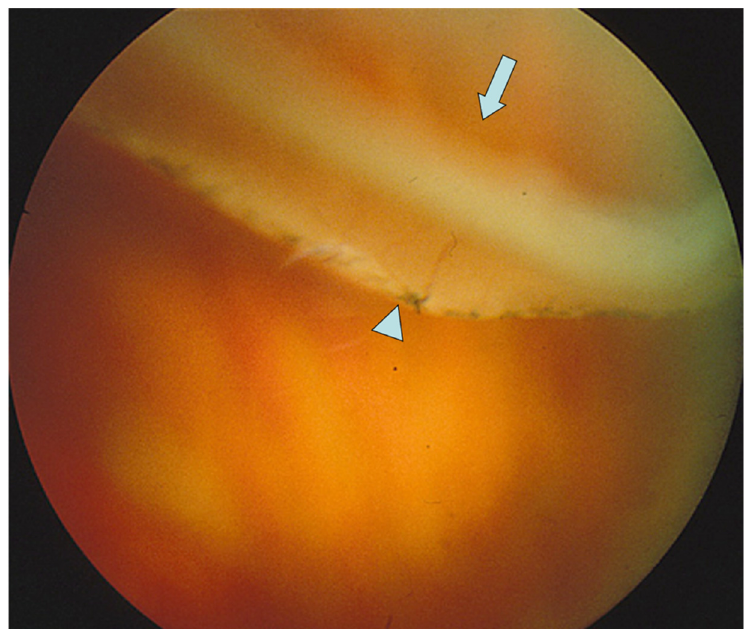
Figure 2. Retinal detachment due to a giant retinal tear in a patient type 1 Stickler syndrome. Note previous laser prophylaxis is too posterior to prevent detachment. Arrow = Giant retinal tear, arrow head = equatorial laser prophylaxis. Reproduced with permission from Snead, MP (2022): Retinal detachment in childhood. Chapter in: Paediatric Ophthalmology and Strabismus 6th Edition. Editors Lyons C & Hoyt C. Elsevier Saunders. In press.